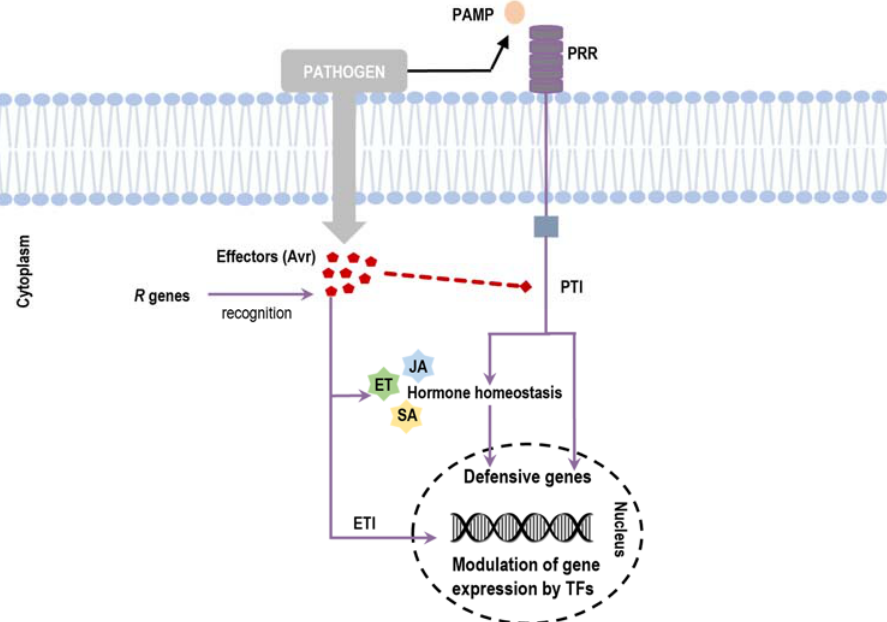
Figure 1. Recognition of a pathogen by the plant and induction of active immune response. Pathogen ‐ associated molecular patterns (PAMPs) are perceived by plant transmembrane pattern recognition receptors (PRRs), which induce signaling cascades and lead to PAMP triggered immunity (PTI). During pathogen attack, pathogens produce effectors molecules (Avr) to increase their pathogenicity into the host cells to suppress PTI and to interfere with hormonal balance. Plants having corresponding resistance (R) genes recognize effectors and activate immune responses (effector-triggered immunity, ETI). After recognition, it is triggered the transcription of the cascade of plant defense mechanisms, and the activation of genes to a robust and quick defense response is induced. ETI response may include altering chromatin configuration that further facilitates access by transcription factors (TFs). Adapted from